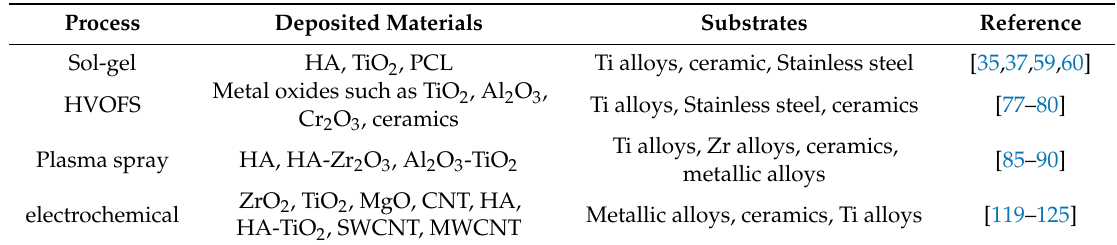
Table 4. Summary of materials deposited on di ff erent substrates via various coating